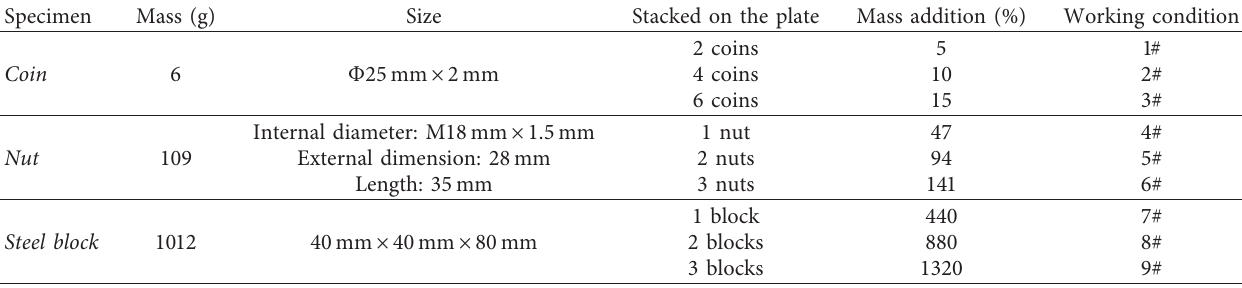
Table 1: Size and mass of specimens.